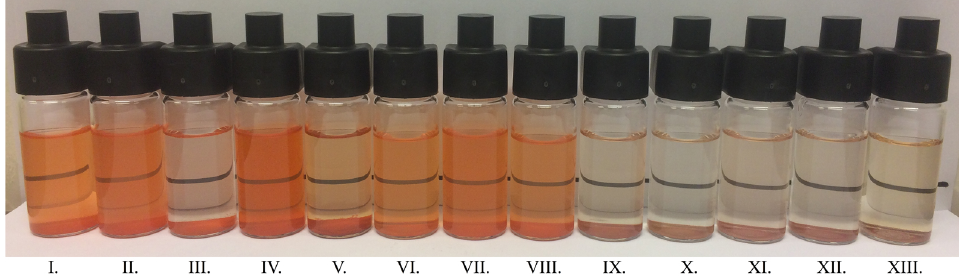
Figure 10. CRB and PB microcapsules dissolved/dispersed in water after 40 days of the physical stability study (0.3 mg/mL). From left to right: I: CRB-MD , II: CRB-Sucrose, III: CRB-Whey, IV: CRB-encap, V: CRB, VI: CRB-MD-CMC, VII: CRB-MD-GA, VIII: CRB-MD-Pectin, IX: PB-MD, X: PB-Whey, XI: PB-Sucrose, XII: PB-MD-GA, XIII: